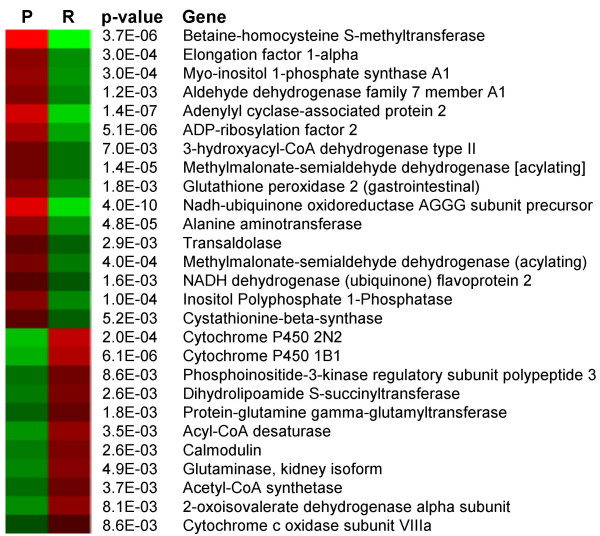
All polluted sites versus all reference sites. Heat map, p-values, and gene expression increased (red) and decreased (green) in a comparison of all polluted sites (P) versus all reference sites (R).